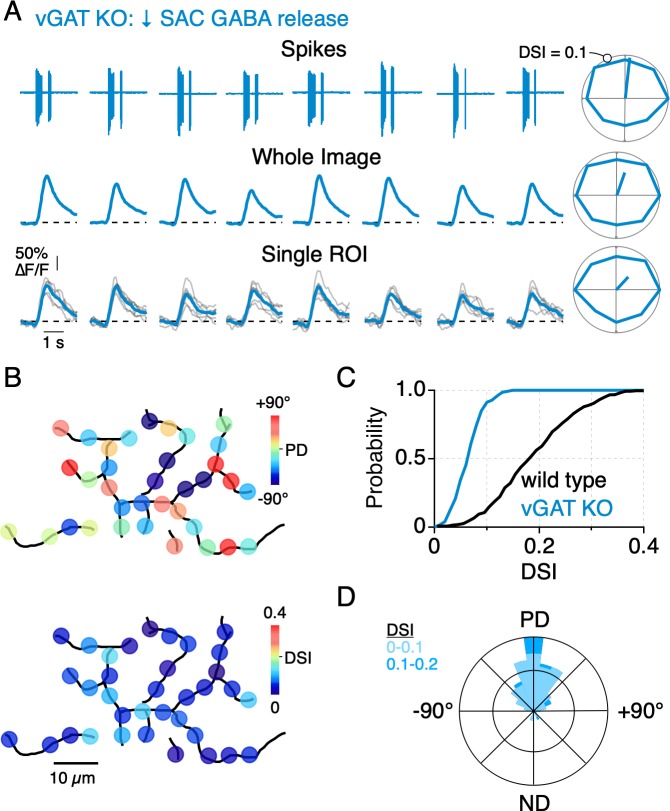
Dendritic Ca2+ signals are untuned when SAC inhibition is compromised.(A) Spiking response and Ca2+ signals from a genetically labeled ON-OFF DSGC in vGAT KO mice, in which the vesicular GABA transporter is knocked out of SACs, preventing them from releasing GABA to DSGCs (Slc32a1fl/fl::ChatCre). Right, Polar plots of the spike rate and the peak Ca2+ responses over the whole image and over a small ROI. Lines extending from the origin indicate the preferred direction and the DSI (note, DSI scale is from 0 to 0.1). (B) Maps of the PD (top) and DSI (bottom) at dendritic ROIs in vGAT KO mice. (C) Cumulative distribution of the DSI from wild type and vGAT KO mice. (D) Rose plot of the preferred direction of dendritic ROIs in vGAT KO mice. Colors indicate the proportion of ROIs within different ranges of DSI. Note. subtle asymmetries present in the spiking responses, which would usually be considered ‘non-directional’ (Pei et al., 2015), were also present in the dendritic Ca2+ responses measured in the absence of NaV activity. Although the Ca2+ signals extracted from single ROIs in the dendritic tree were weakly tuned for direction, they encoded a similar direction to the spiking response, indicating that their weak tuning did not arise from technical noise sources.Figure 3—figure supplement 2—source data 1.Spiking responses, calcium responses, and tuning in DSGCs in the vGAT KO mouse.